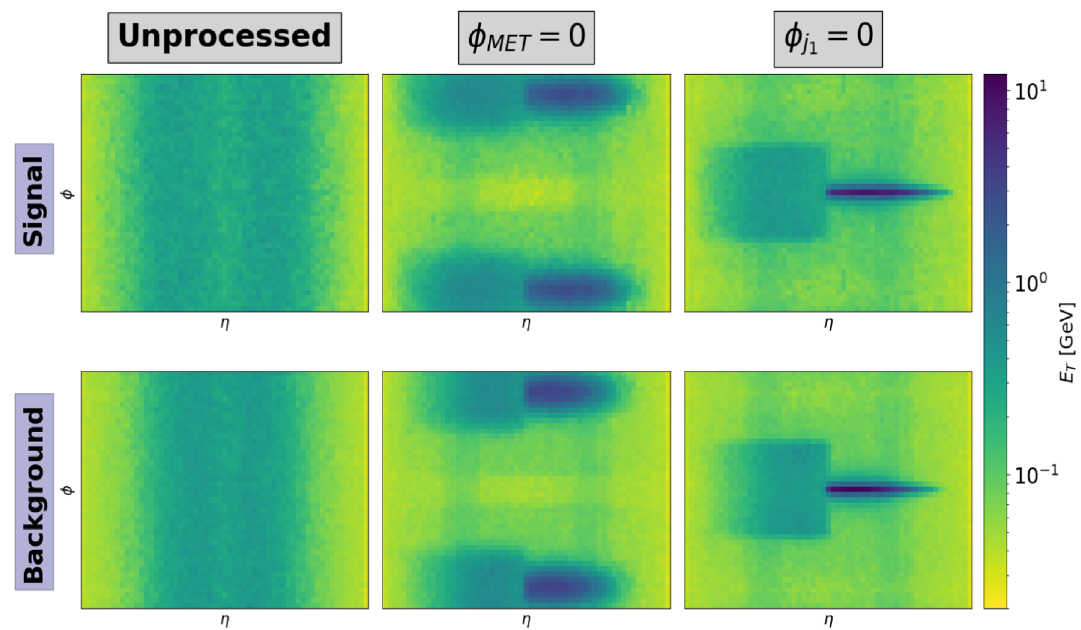
Fig. 9 Average of 25,000 low-resolution tower-images of (left) unpro- cessed, (center) processed image with φ met = 0 and (right) φ J = 0 for (top panel) signal and (bottom panel) background classes. The images are binned in the full range of the tower: η ∈ [− 5 , 5 ] and φ ∈ [− π,π) . Wecanseethataswegofromlefttoright,thereisadiscernibleimprove-